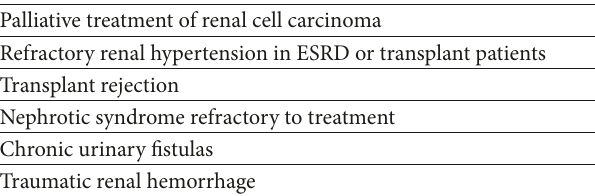
Table 1: Reported indications of renal